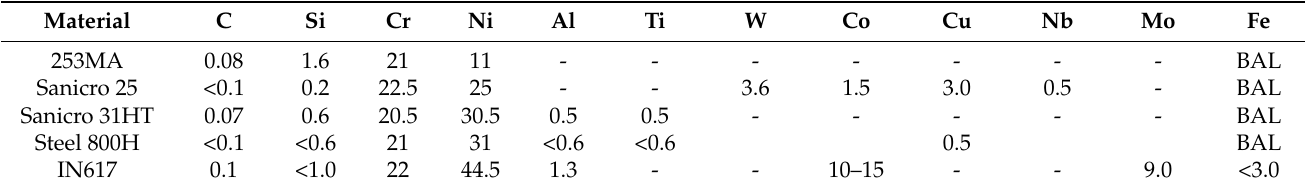
Table 2. Preliminary structural alloy list for the SOLEAD system, (% wt).